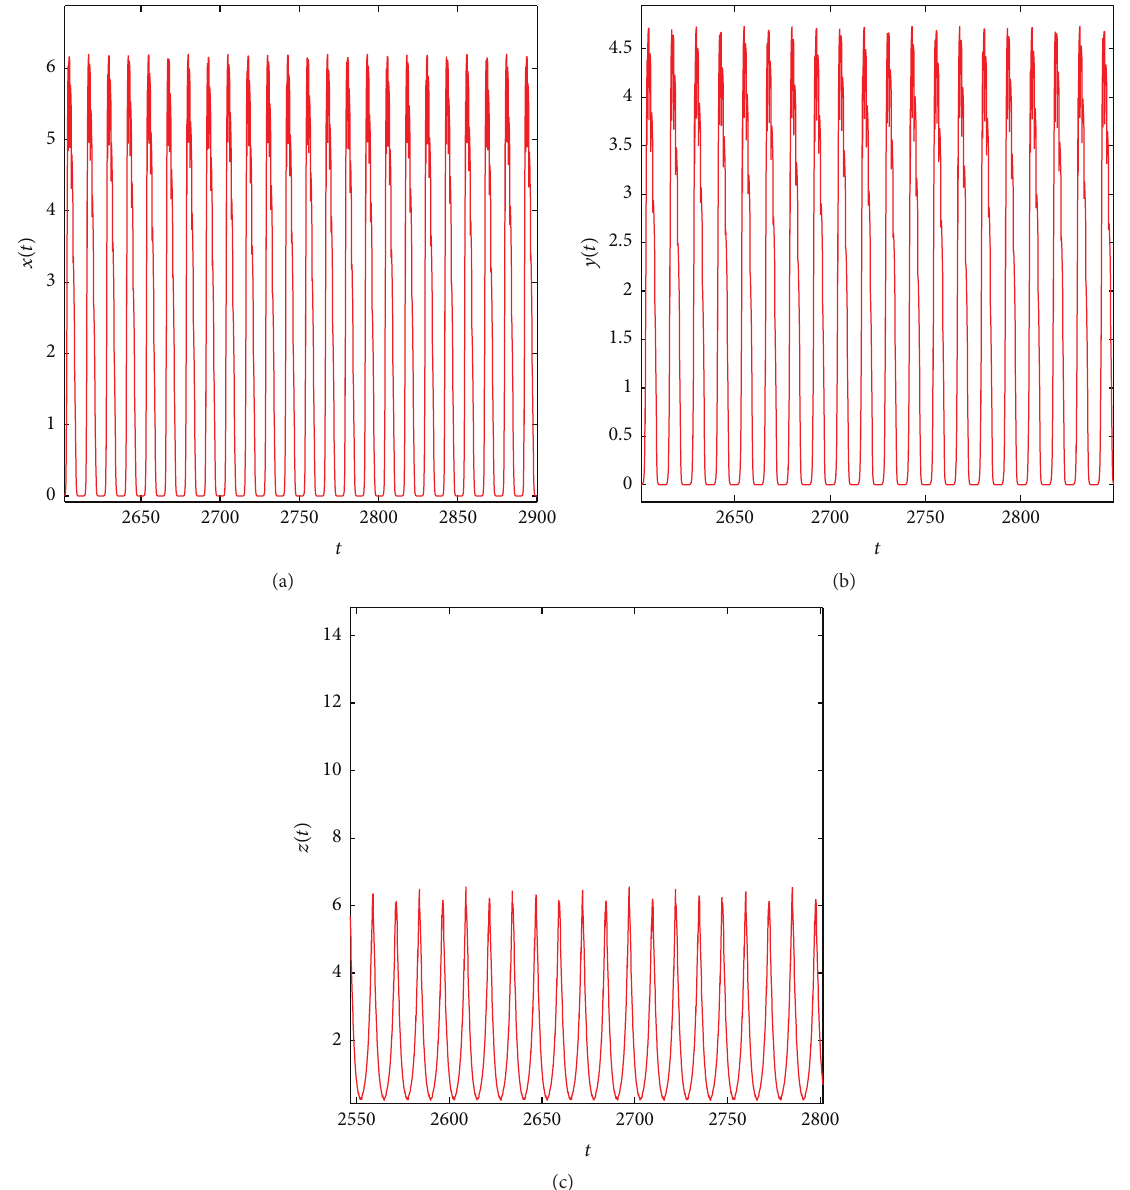
Figure 7: (a)–(c) Time series of prey 𝑥(𝑡) and 𝑦(𝑡) and predator 𝑧(𝑡) depicting coexisting populations of system (2) with mixed Holling type II–IV functional responses in presence of seasonal perturbation with data set (45) and 𝑃 = 0.1